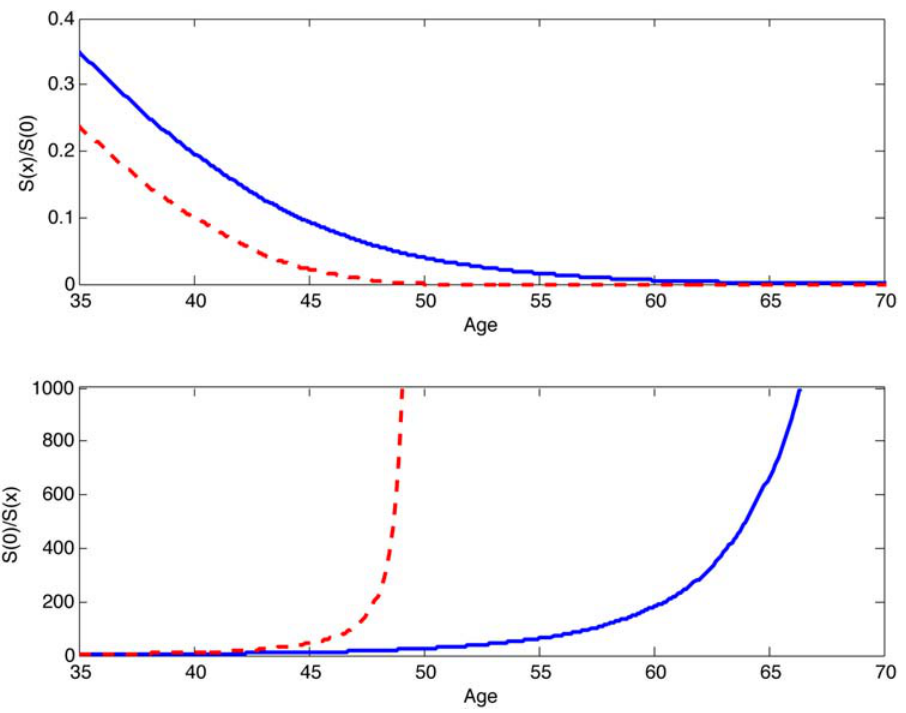
Figure 4. Two-sex model eliminates wall of death. In a the dashed red line shows the relative force of selection (as in Fig. 1) on a forager population with a life expectancy of 33.5 years using female-only demography. The solid blue line shows the two-sex relative force of selection and reveals an active defense against deleterious mutations into the 65–70 yr age interval. b shows the inverse of the force of selection, which describes the pattern of mortality. The wall of death is replaced by a gradual rise in mortality until very late ages.